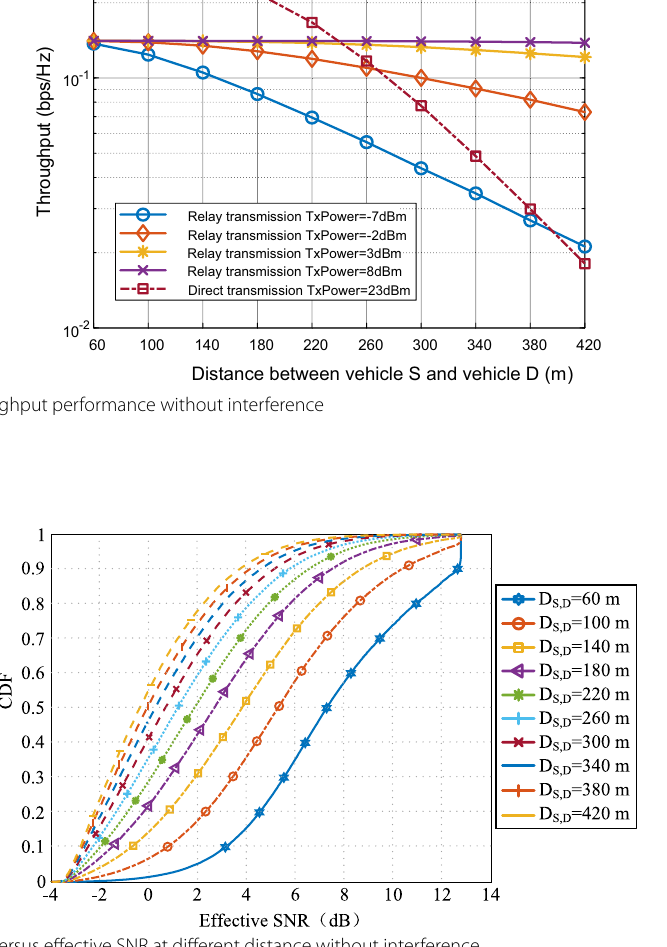
Fig. 15 CDF versus effective SNR at different distance without